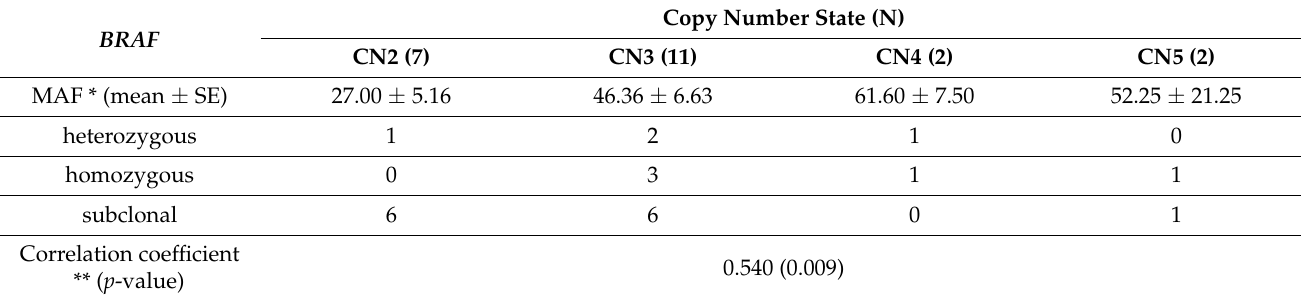
Copy Number State